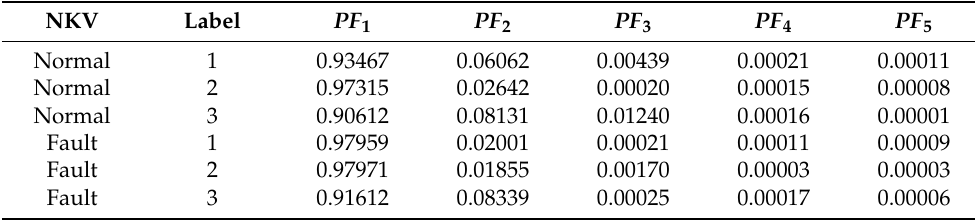
Table 2. NKVs of different PF s obtained by decomposing sets of normal and arc data. NKV